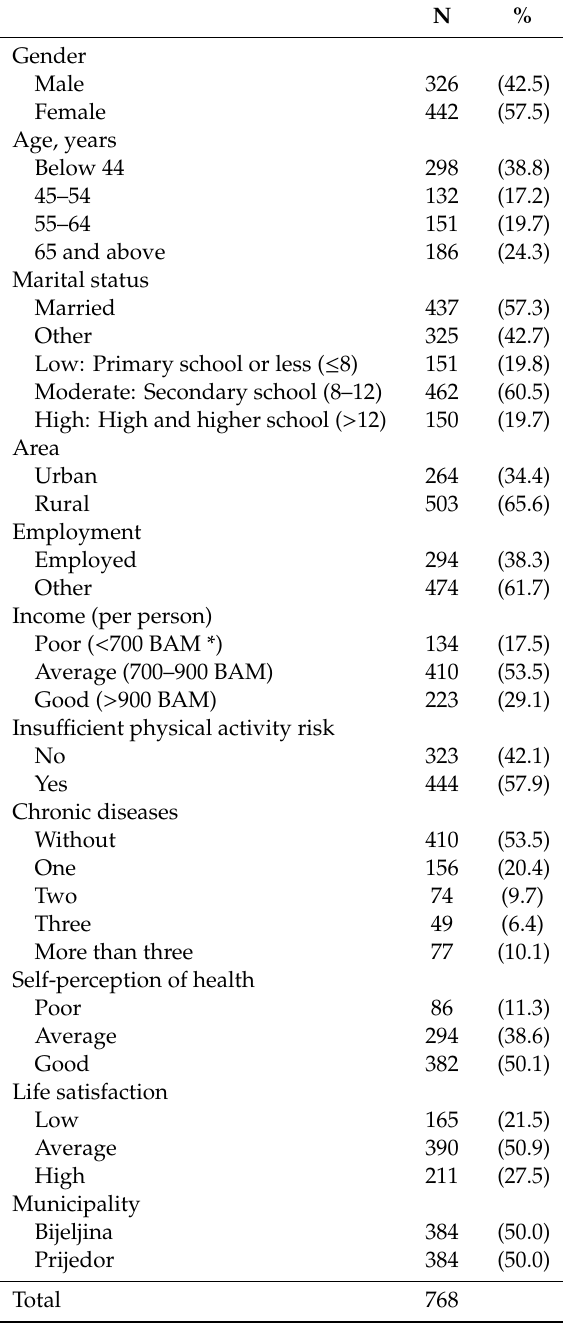
Table 1. Socio-demographic characteristics of